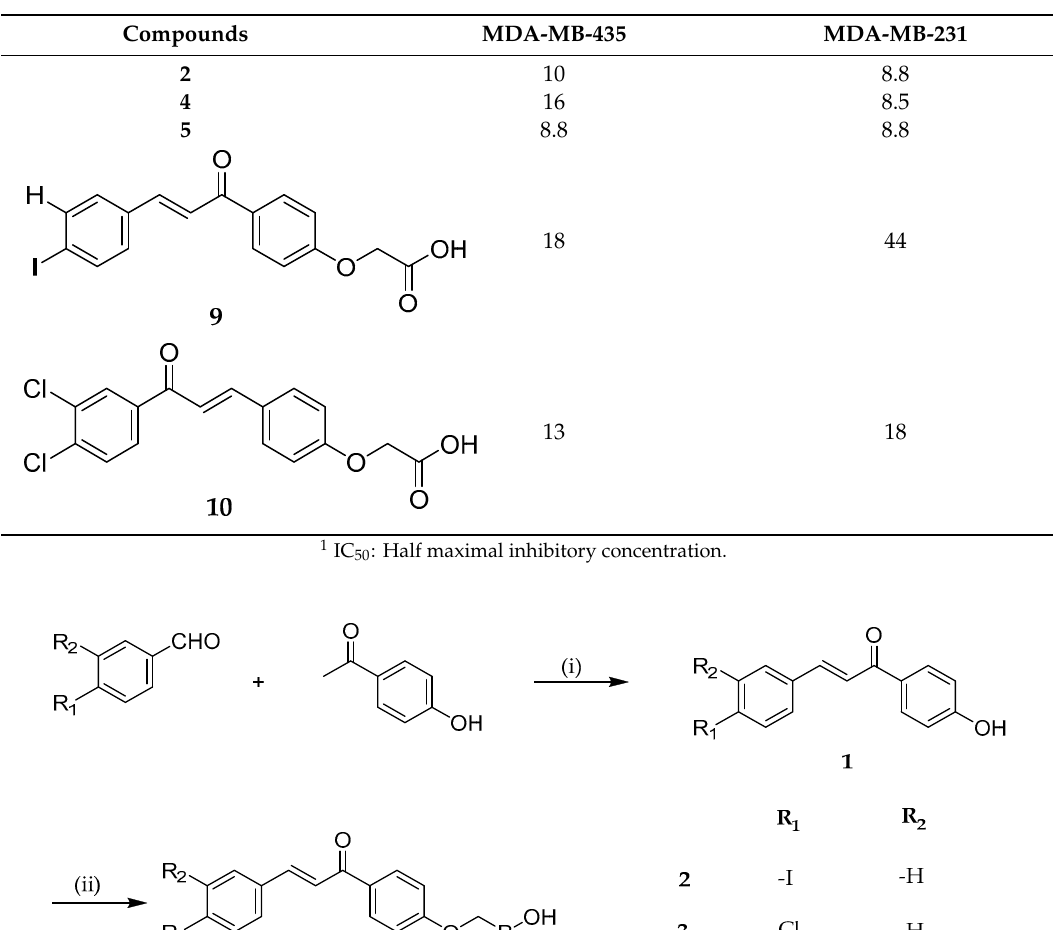
Table 2. Growth inhibition (IC 50 1 , μ M) effect of chalcone ‐ boronic acids ( 2 , 4 , and 5 ) and chalcone ‐ carboxylic acids ( 9 and 10 ) analogues in breast cancer cell lines.